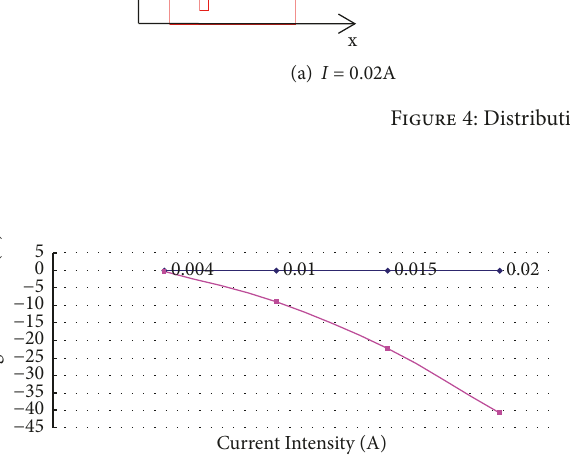
Figure 5: Curve of electromagnet force changes with current